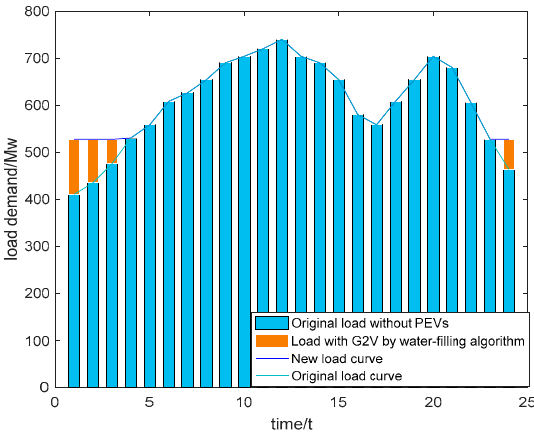
Figure 8. New 24-h load curve after valley filling.